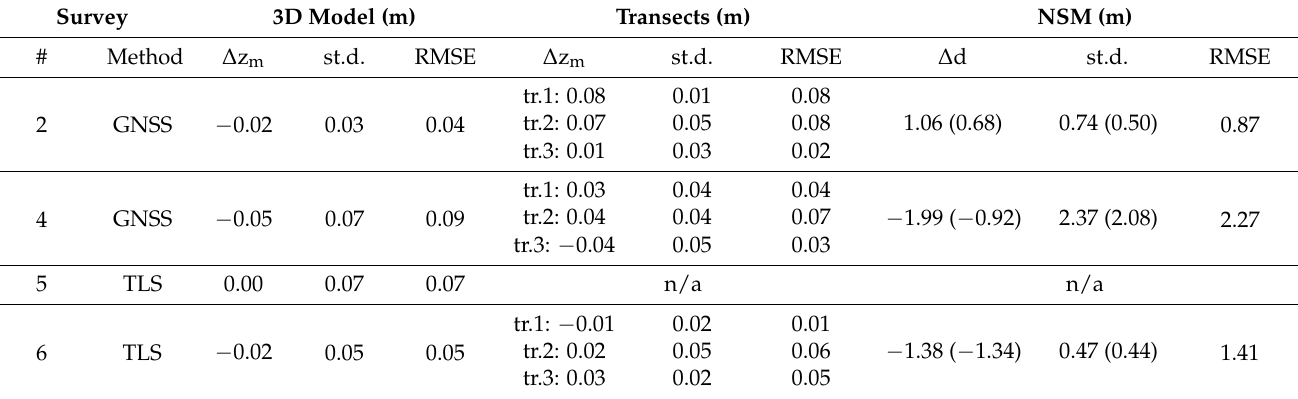
Table 2. Synthesis of the comparison between field measurements (GNSS-TLS) and remote data (VISTAE). 3D elevation model and transects refer to vertical distances, while the NSM (Net Shoreline Movement) obtained by means of DSAS indicates horizontal distances (MATLAB results are between parentheses). “ ∆ z m ”, “st.d.” and “RMSE” stand for mean difference, standard deviation and root mean square error, respectively. “tr1”, “tr2” and “tr3” stand for transects 1, 2 and 3, respectively. Survey 3D Model (m) Transects (m) NSM